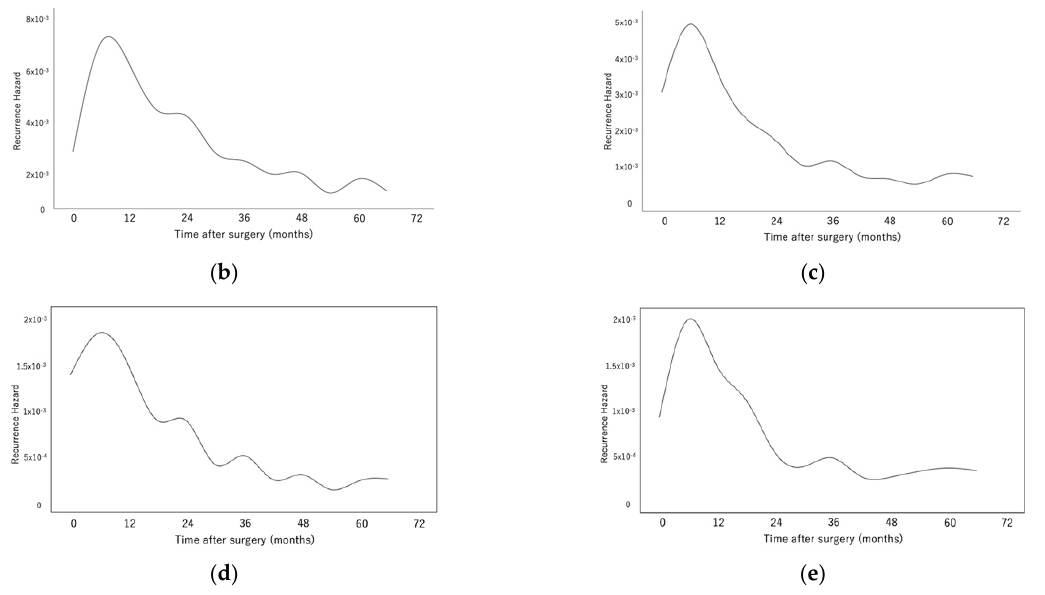
Figure 2. ( a ) The monthly recurrence hazard function of the entire patient population. The major peak of recurrence was 9 months after surgery. ( b – e ) The recurrence hazard functions for intrathoracic recurrence ( b ), extrathoracic recurrence ( c ), bone metastasis ( d ), and brain metastasis ( e ). Figure 3a shows a comparison of the recurrence hazard according to tumor histology.